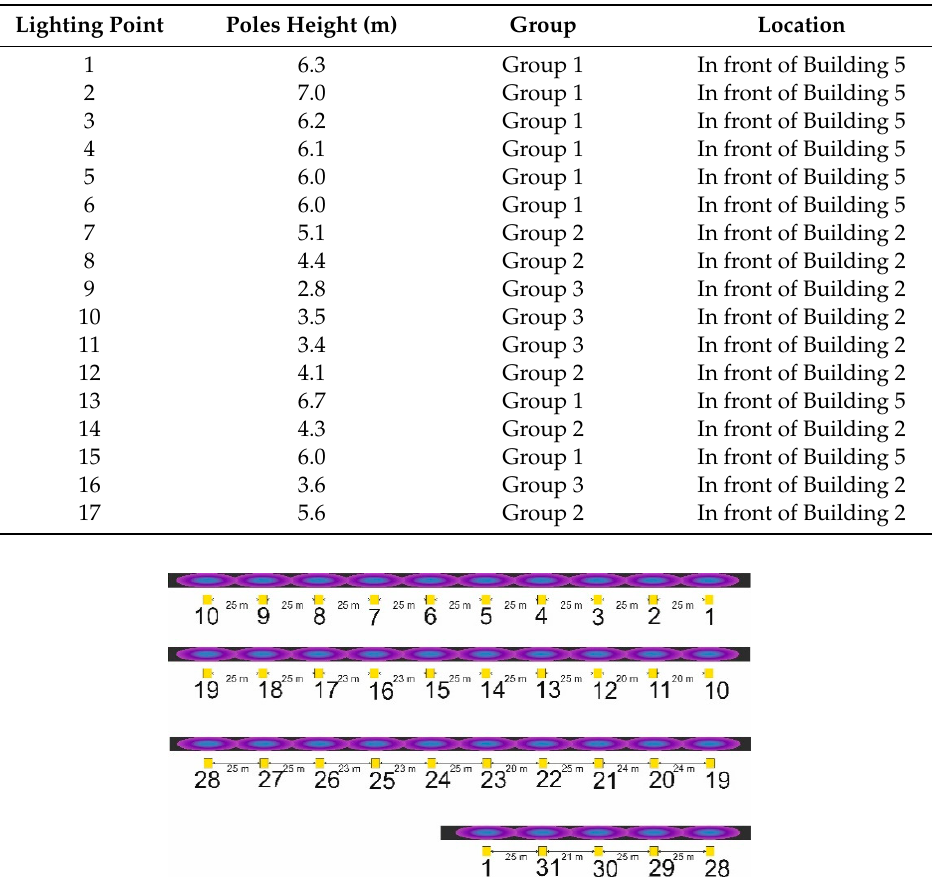
Table 4. Simulation results of Alternative 3.